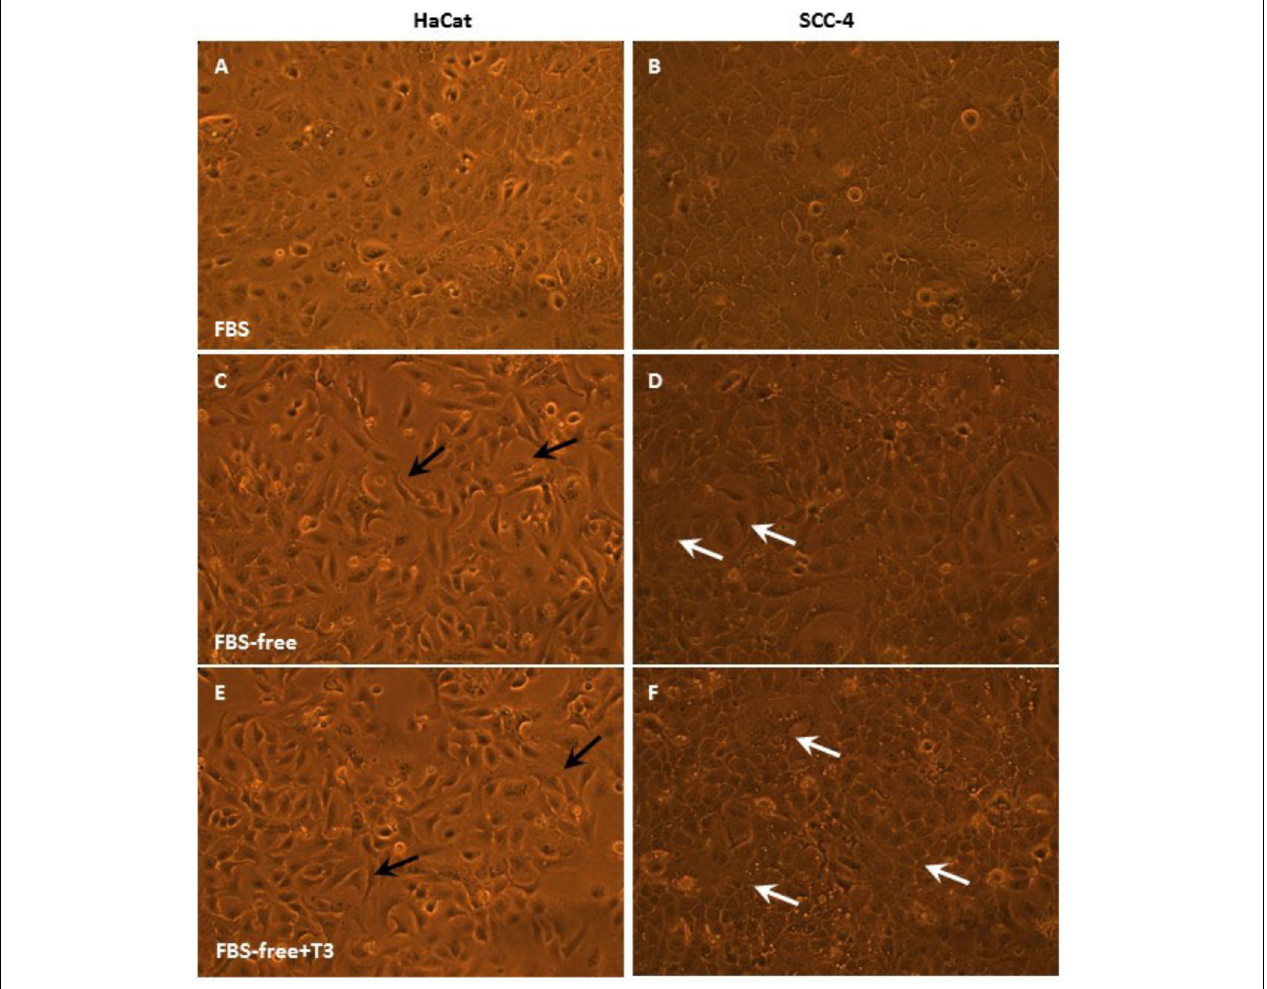
FIGURE 3 | Phase-contrast microscopic images of HaCat and SCC-4 cells in medium containing 10% FBS, medium without serum (FBS-free), and treated with T3 in medium without serum (FBS-free+T3). In the SCC-4 line, cells grown in T3-treated and FBS-free medium showed more disorganized cell–cell contacts (C,D) compared with those of cells maintained in serum-containing medium (A,B) . White arrows indicate large cytoplasmic volume (D,F) and black arrows cytoplasmic processes (C,E)